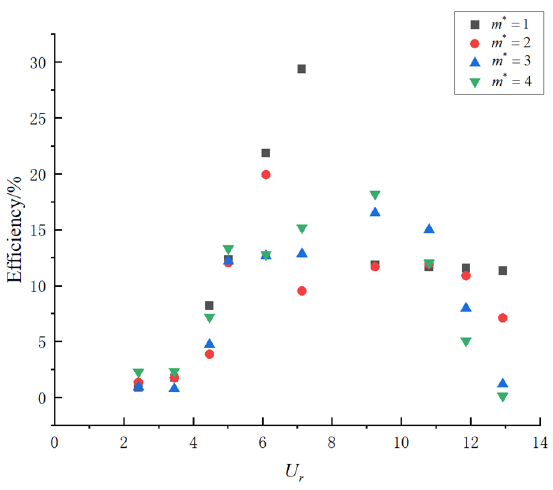
Figure 8. The relationship between mass ratio and energy